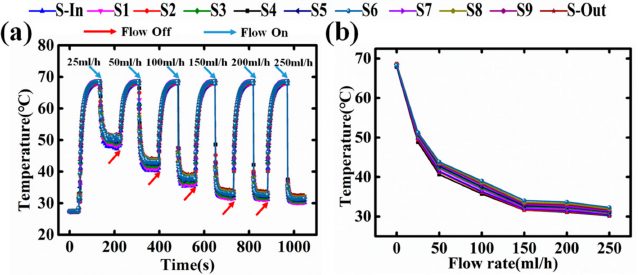
Figure 4. ( a ) Temperature sensors response under different flow rate (25 mL/h, 50 mL/h, 100 mL/h, 150 mL/h, 200 mL/h, 250 mL/h) with the condition of flow off or flow on; ( b ) The temperature profile in the micro-fluid channel under different flow